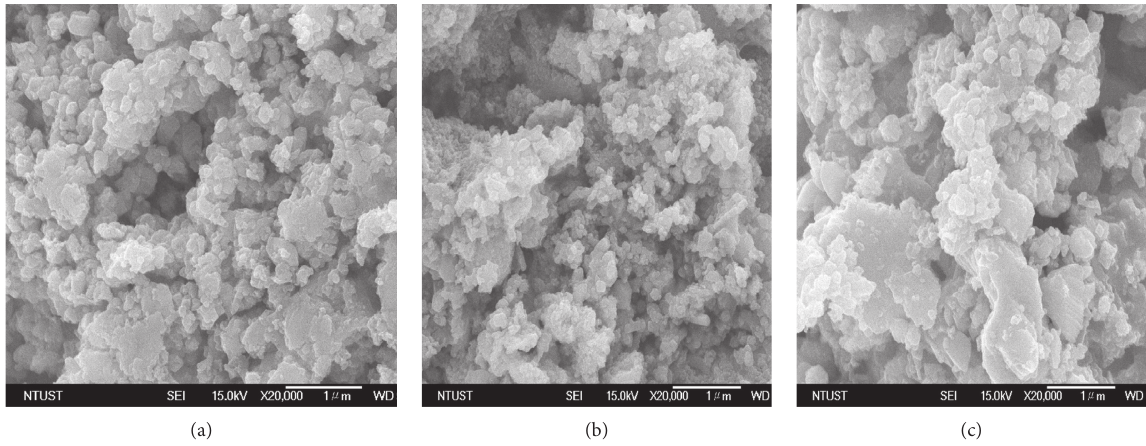
Figure 3: SEM images of CuO NPs synthesized using copper (II) nitrate trihydrate and Catha edulis leaf extract in different ratios (w/v) (a) 1:10, (b) 3 :10, and (c) 1:2.